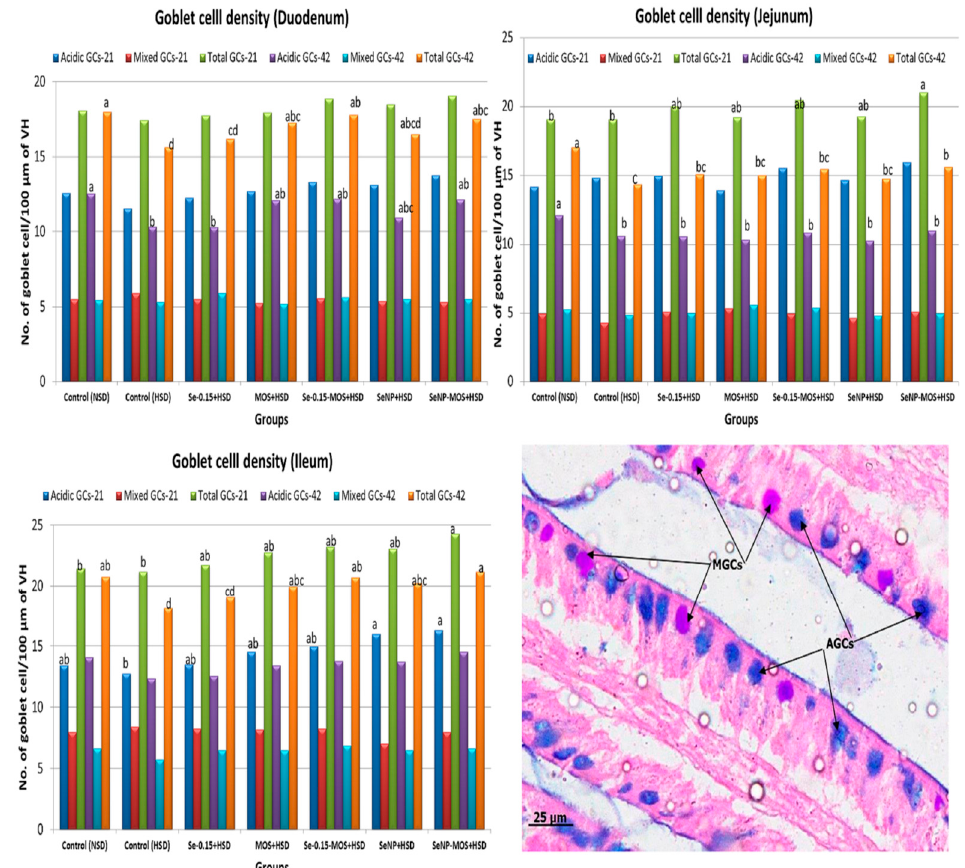
Figure 3. Graphs comparing the goblet cells density in the segments of small intestine on day 21 and day 42 among groups. The data bar height shows the number of goblet cells per 100 µm of the middle portion of villus height in the two-dimensional image. These values represent the means of eight replicates per group (16 birds per group). NSD: normal stocking density, HSD: high stocking density, Se: selenium selenite, MOS: mannan oligosaccharide, SeNP: selenium nanoparticles. GCs: goblet cells. Bars of the same color with different letters differ significantly between groups. The micrograph in the right lower corner shows the AGCs (acidic goblet cells) and MGCs (mixed goblet cells). (PAS-AB stained, 40×).